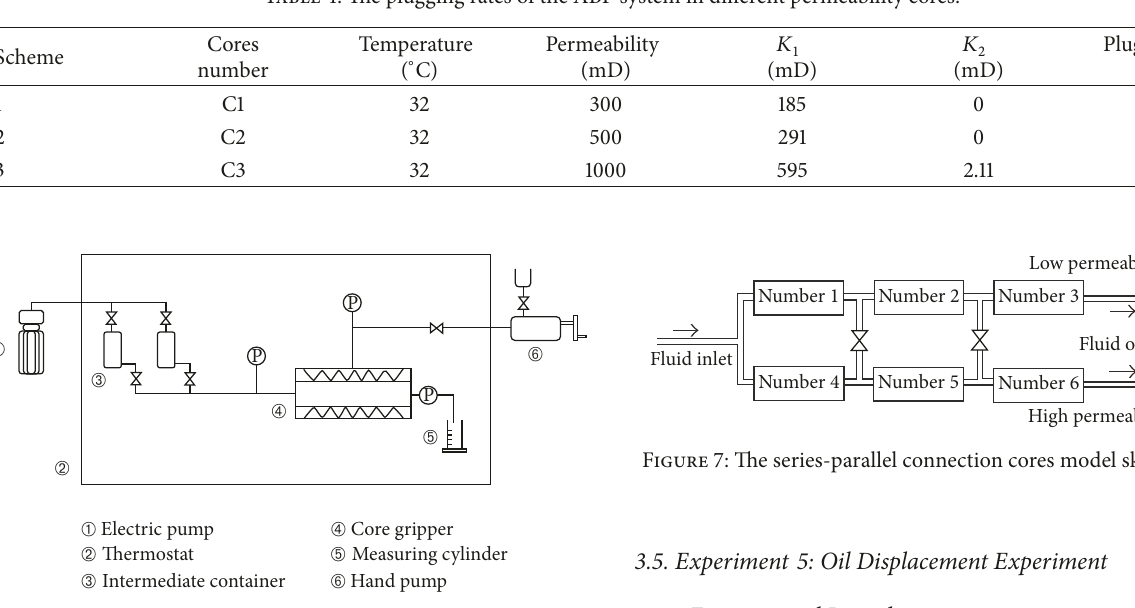
Figure 6: Core flow experiment device flowchart.